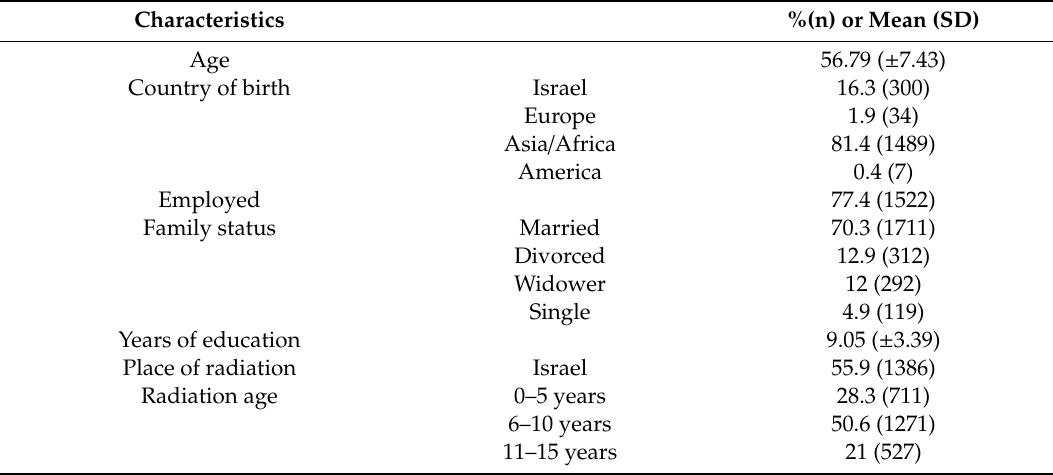
Table 1. Study Participant